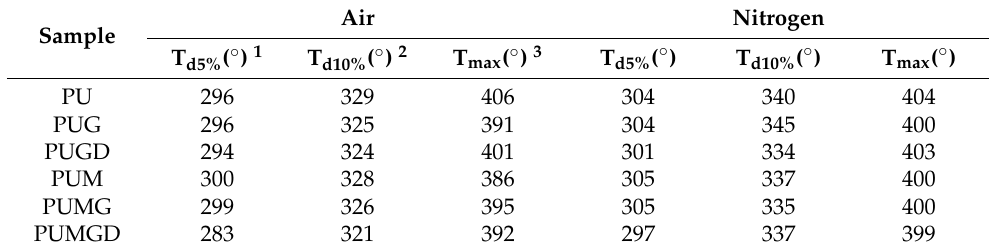
Table 5. TGA data for polyurea